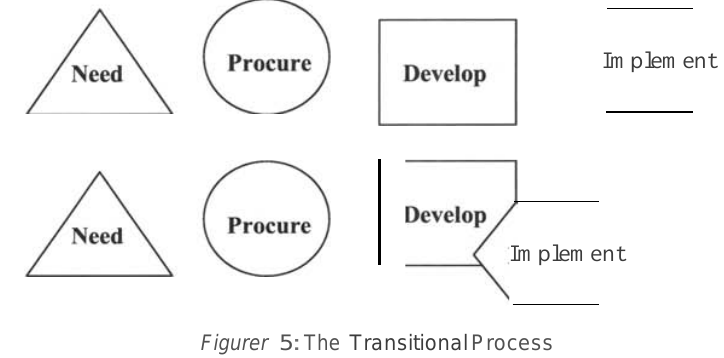
Figurer 5: The Transitional